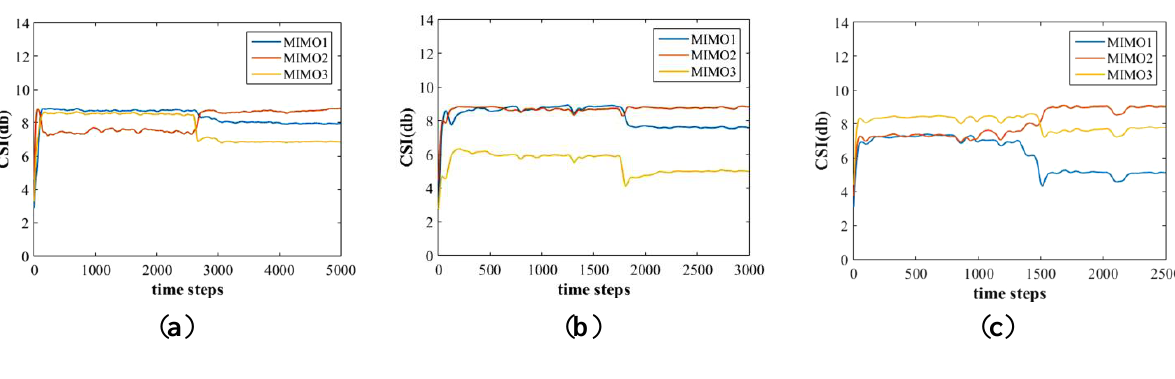
Figure 4. The MIMOs subplots for an action (e.g., squatting down to pick up something from the standing state) performed in three different orientations ( a – c